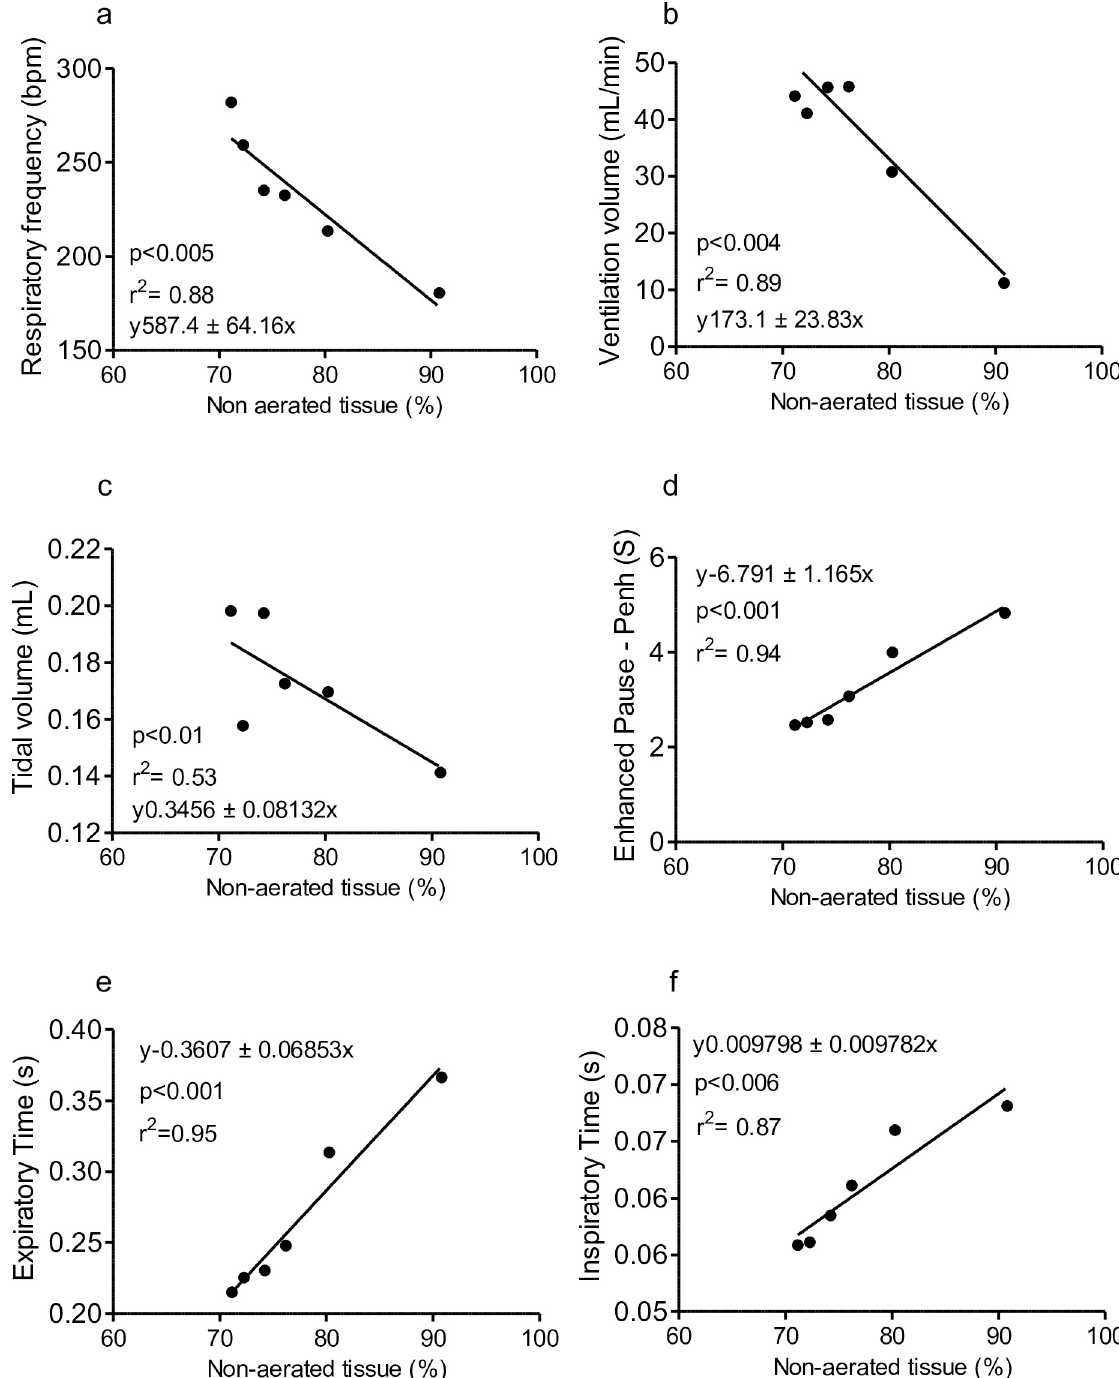
Fig 4. Correlation between non-aerated lung tissue by computed tomography with respiratory parameters during malaria-associated ARDS. (a) Strong negative correlation between decreased respiratory parameters with increased non-aerated CT tissue (p < 0.005). (b) Moderate negative correlation between volume per minute of ventilation with increased non-aerated CT tissue. (c) Moderate negative correlation between tidal volume with the increase of non-aerated CT tissue (p < 0.01. (d) Strong positive correlation between increased respiratory pause with the presence of non-aerated CT tissue (p < 0.001). (e) Strong positive correlation between expiration time with increased non-aerated CT tissue (p < 0.001). (f) Strong positive correlation between inspiratory time with increased non-aerated CT tissue (p < 0.006). Data presented as mean ± SD. Correlation: Linear Regression (R2) test, n = 6 mice.